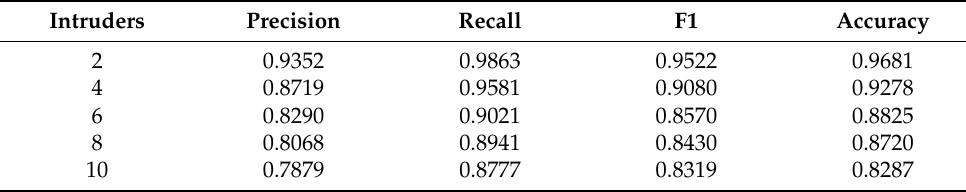
Table 3. The Detection accuracy for different numbers of intruders.